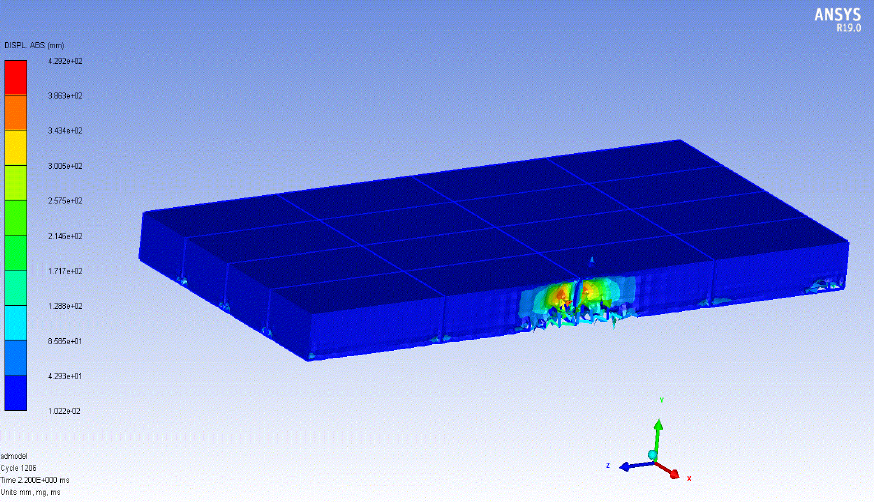
Figure 13. Deformations of the ferry.